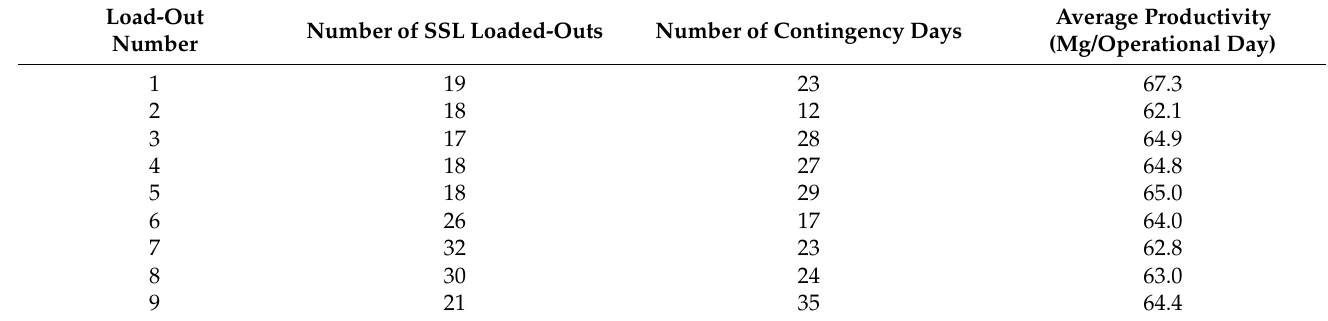
Table 3. Average load-out productivity for nine load-outs over a 46-week season.